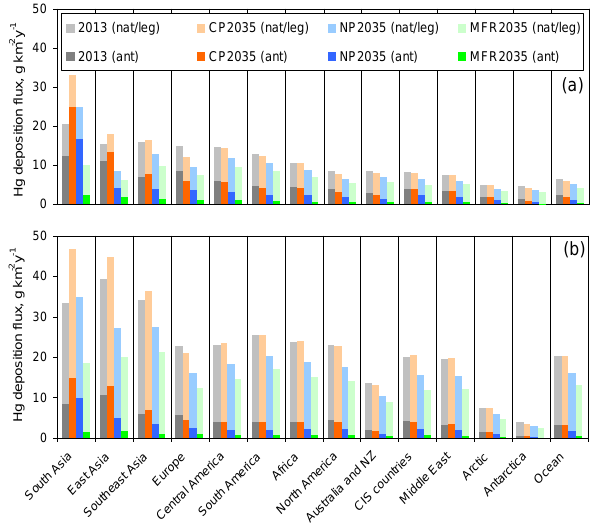
Figure 10. Average mercury deposition flux in various geographical regions in 2013 and 2035 corresponding to the selected emission scenarios as simulated by GLEMOS (a) and ECHMERIT (b).